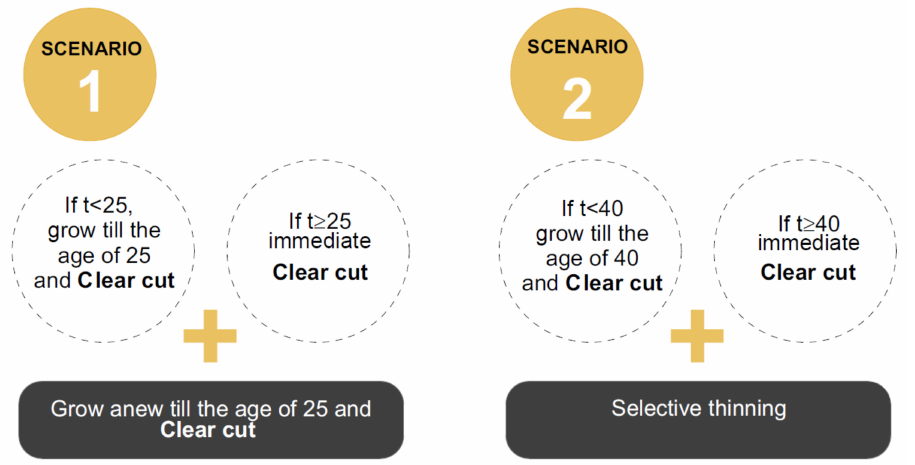
Figure 2. Simulation Scenarios in